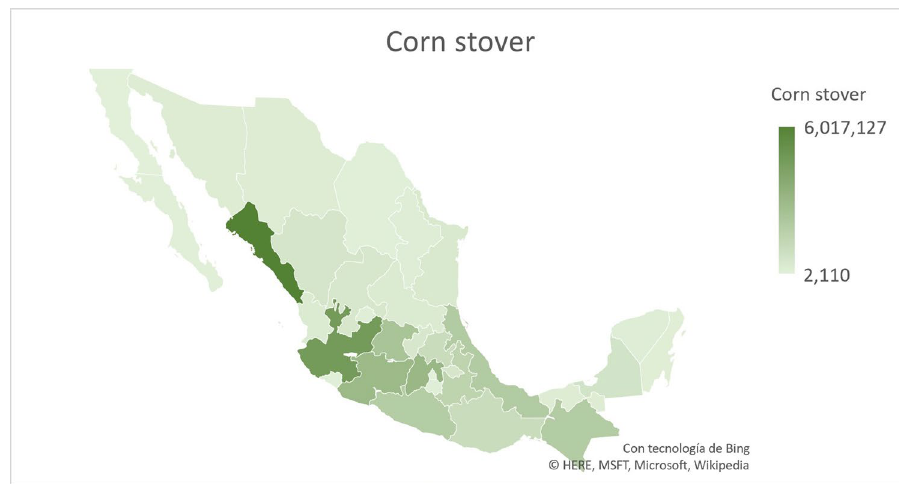
Fig. 3 Corn stover availability (Mg/year)